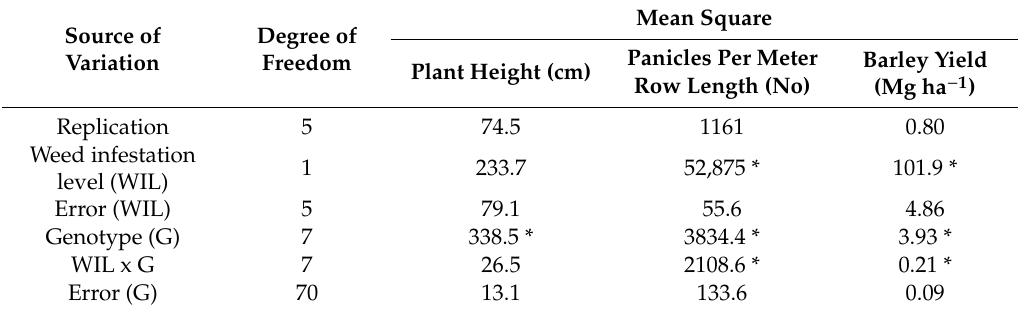
Table 2. Analyses of variance showing the weed infestation level and genotype e ff ects for the final plant height, panicles per meter row length, and yield of